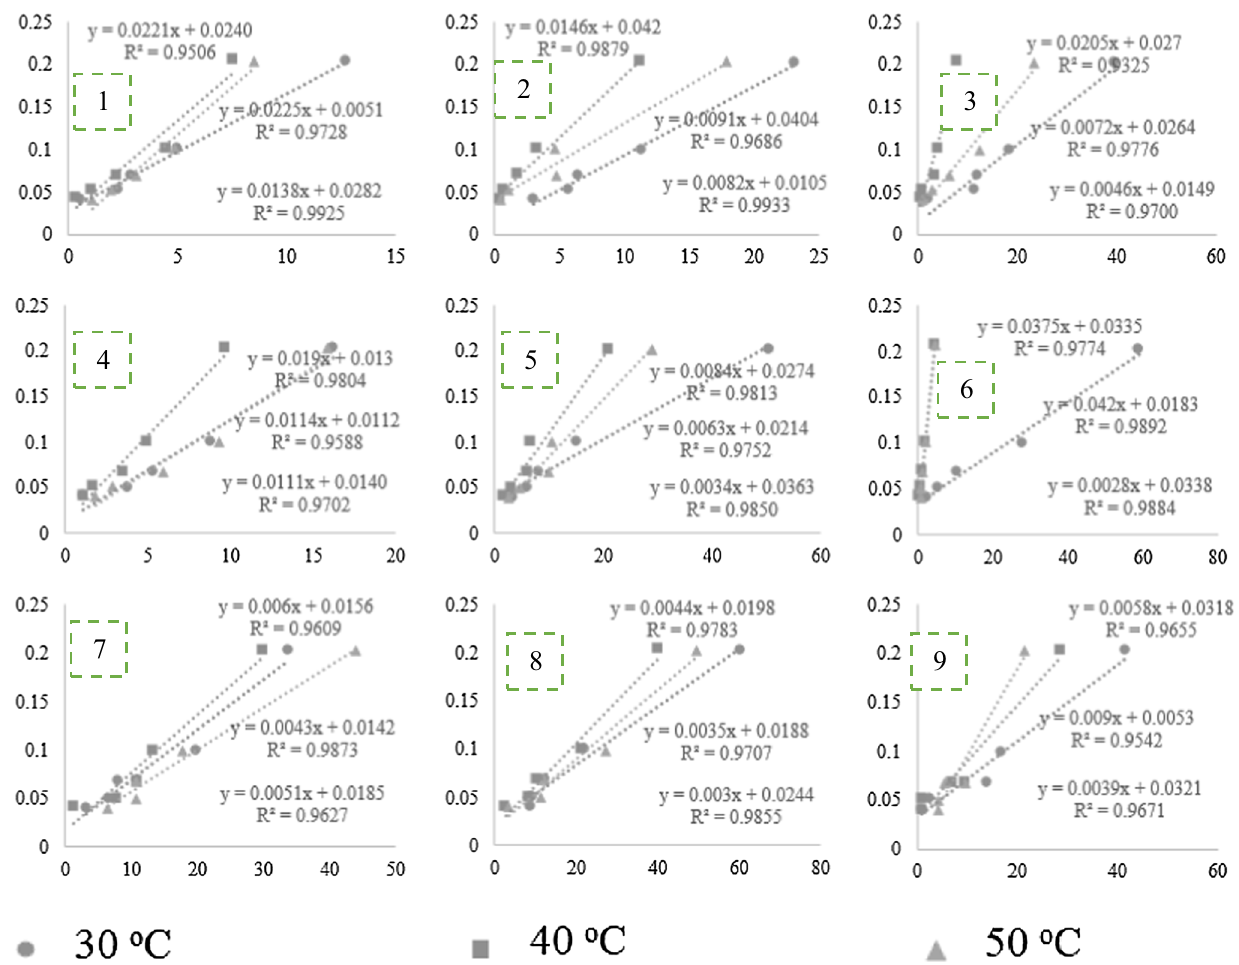
Fig. 5 Langmuir plot of 1/Qe vs 1/Ce for samples C1-700 (1), C2-700 (2), C3-700 (3), C1-750 (4), C2-750 (5), C3-750 (6), C1-800 (7), C2-800 (8), and C3-800 (9) at 30 ℃ , 40 ℃ , and 50